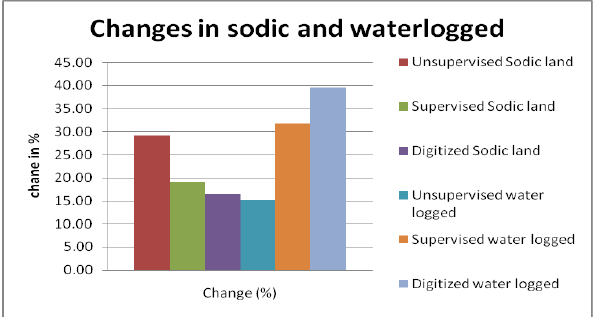
Table 6: Sodic land & waterlogged classes by different techniques